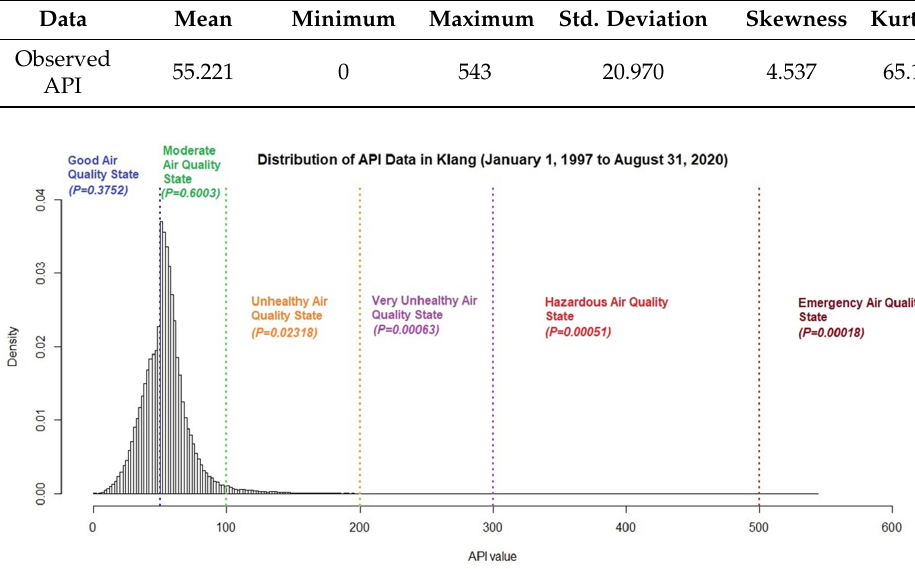
Figure 5. Distribution of API data in Klang corresponds to their air quality status.